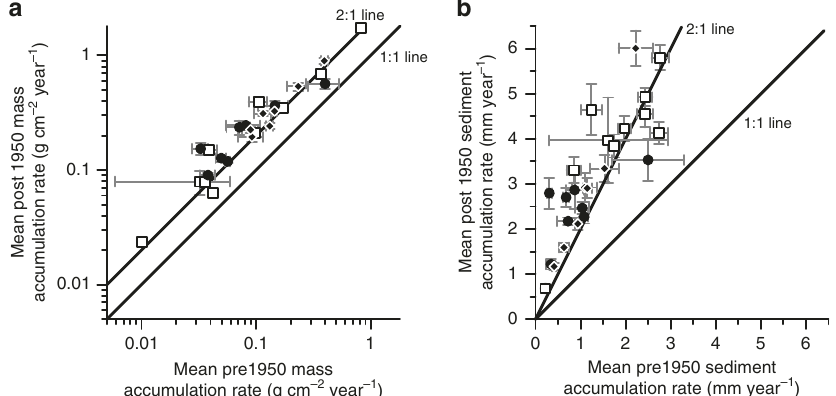
Fig. 5 Mean pre and post 1950 mass accumulation rates and sediment accumulation rates. Mean mass accumulation rates (± mean measurement error; a ) and sediment accumulation rates (± mean measurement error; b ) increased after 1950 at each site except for Sabine Bay. Notice mean mass accumulation rates are plotted using a logarithmic scale. Square = East Coast, FL, and AL ( N = 10). Circle = Louisiana and Texas ( N = 8). Diamond = Cuba, MEX, and West Coast ( N = 7). Data provided in Supplementary Data